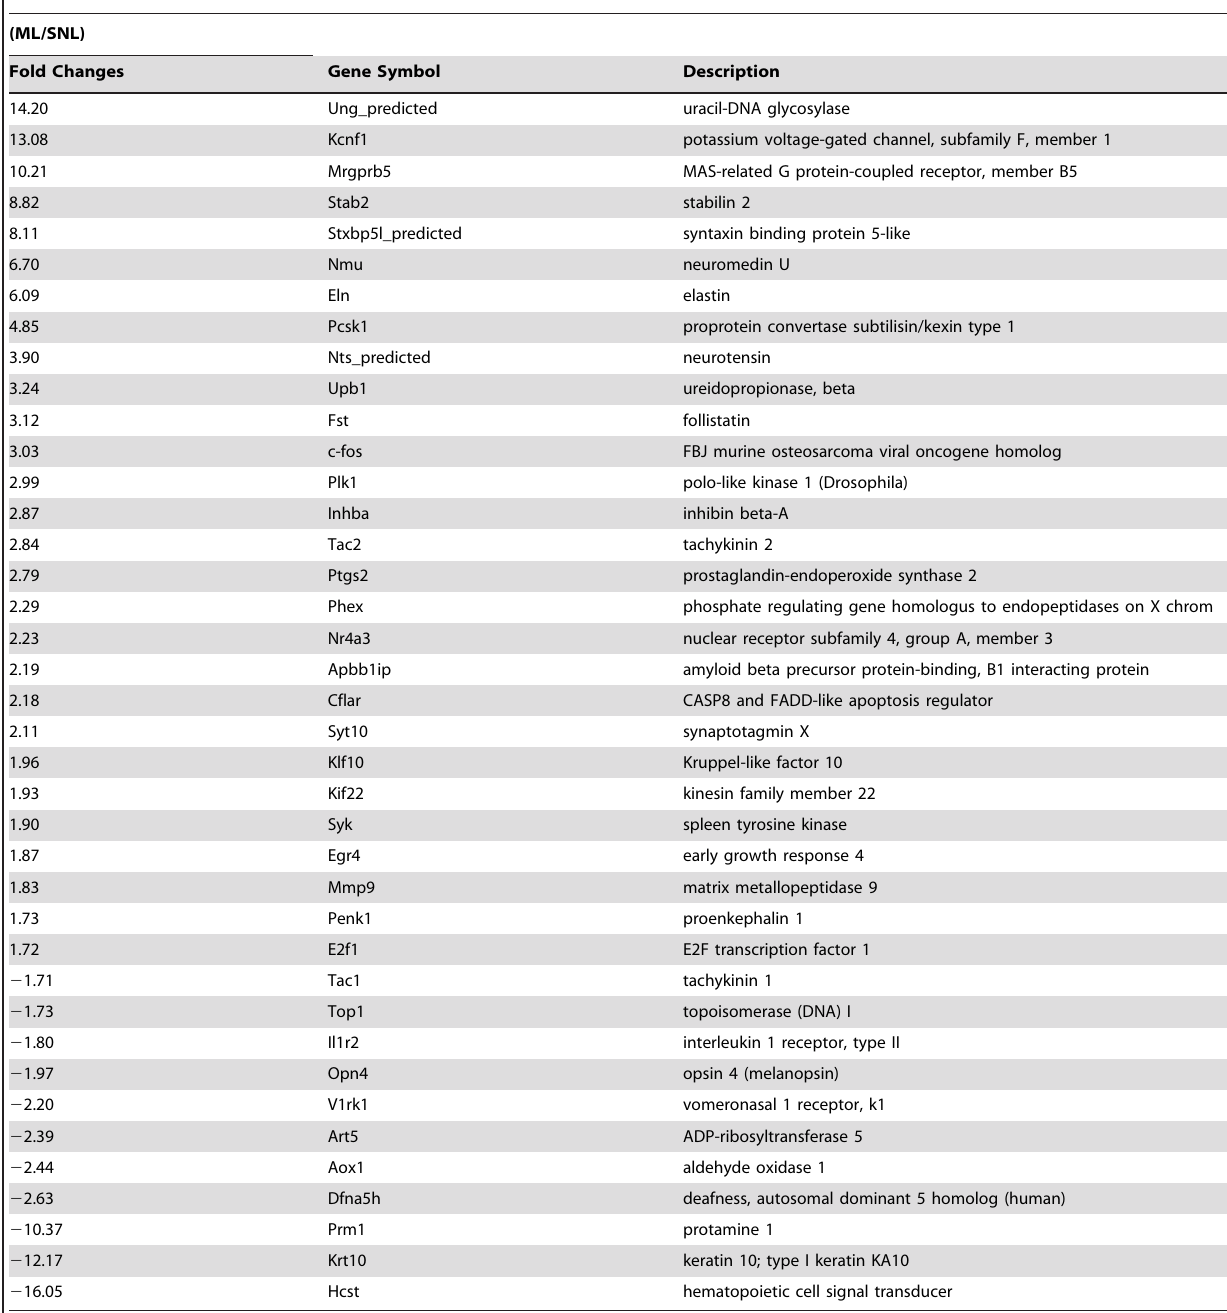
Table 4. Partial list of genes showing METH-induced changes in the DA-depleted striatum.